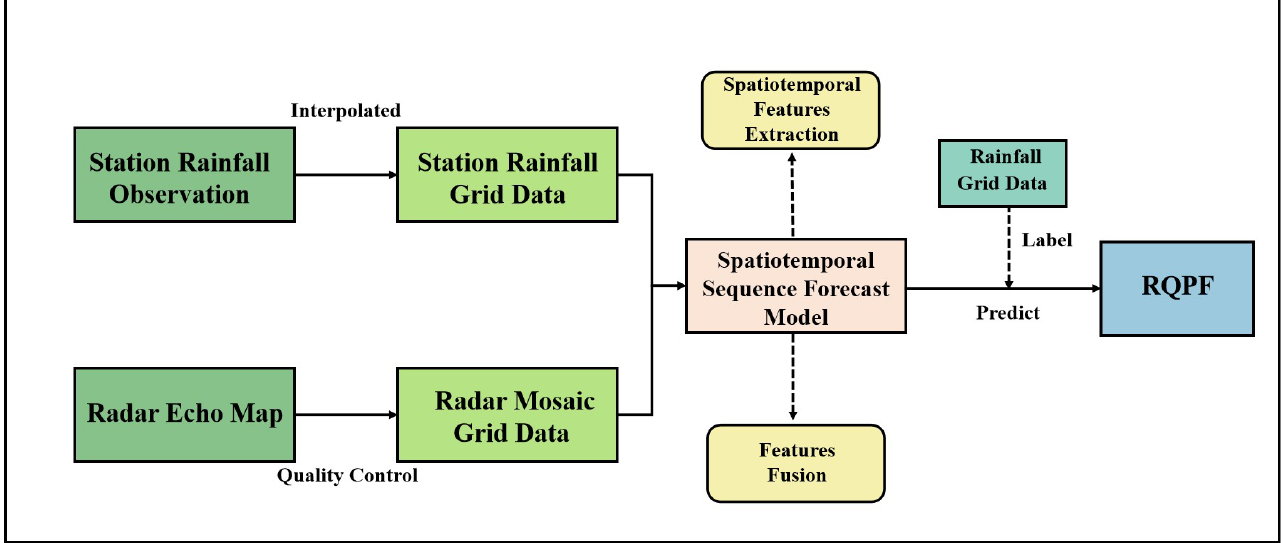
Figure 1. The process of radar quantitative precipitation forcasting